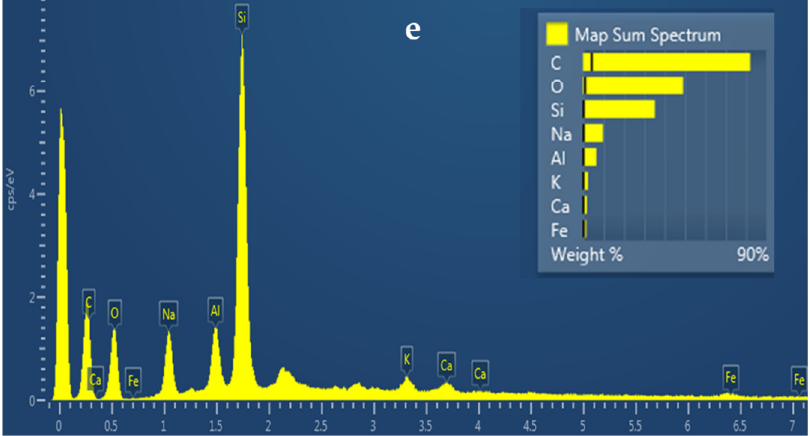
Figure 9. ( a , c ) SEM images of surface and ( b , d ) cross-section for the nanocomposite films of ALG/G/15NZ ( a , c ) and ALG/G/15TO@NZ ( c , d ) respectively. ( e ) Energy dispersive spectrometer (EDS) spectrum and relative elemental analysis of the surface (inset) from the SEM image ( a ).